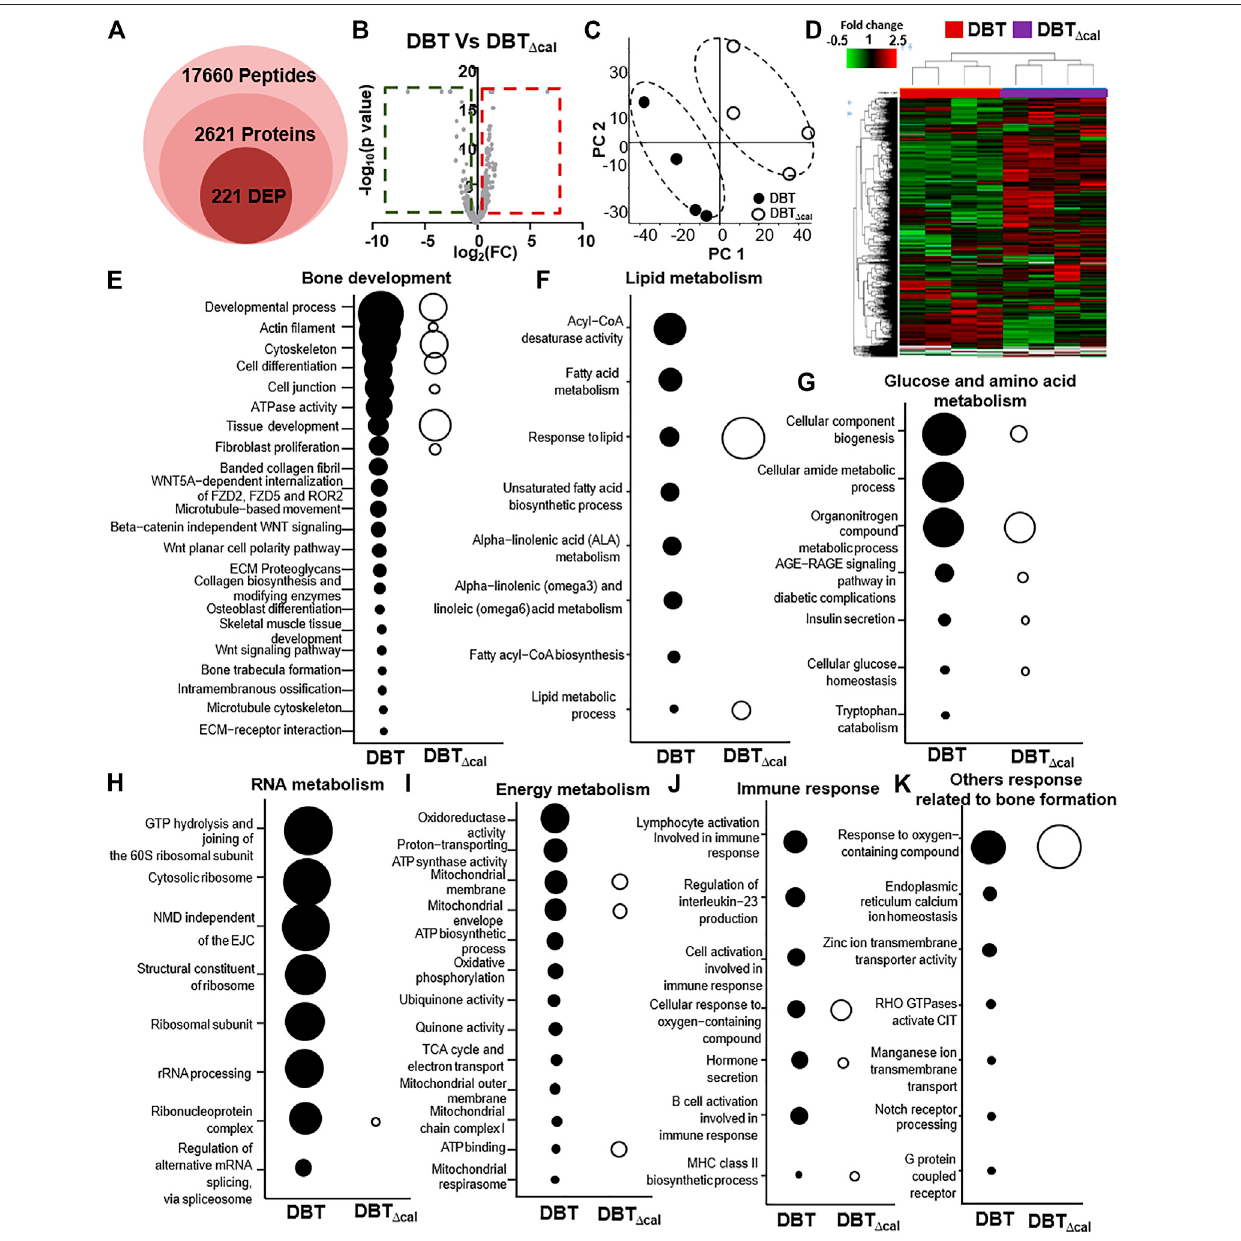
FIGURE 3 | Comparison of proteomics between DBT and DBT Δ cal . The treatment of osteoblasts was as that in Figure 1 . (A): The statistical summary of total detected peptide, protein, and DEP. (B): In MS results for DBT and DBT Δ cal , DEPs are deemed signi fi cant for p < 0.05 and fold change higher/lower than ± 1.5, correspondingtotherectangularregions. (C): PCAandanalysesresolvetheobservationsintotwoclusters.Thecomponents,PC1andPC2,arere fl ectingthehorizontal and vertical axis, respectively. (D): Heat map analysis of identi fi ed proteins. The brightness of each color corresponds to the magnitude of difference when compared with average value. Hierarchical clustering is shown on the top of the map. (E – K): KOBAS analysis enriches the signaling pathway in DEGs via KEGG, Reactome, BioCye, PANTHER, and GO. The size of the circle represents – log 10 (P).